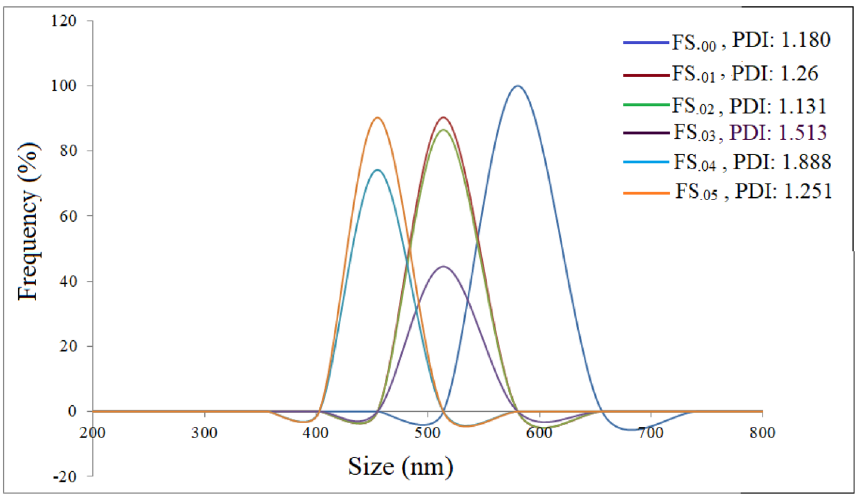
Figure 10. DLS diagrams of the ferrofluids, as marked on